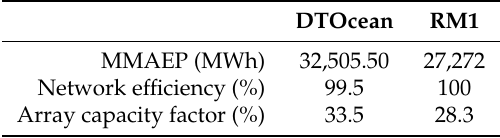
Table 6. Comparison of 10 TEC energy production and transmission.